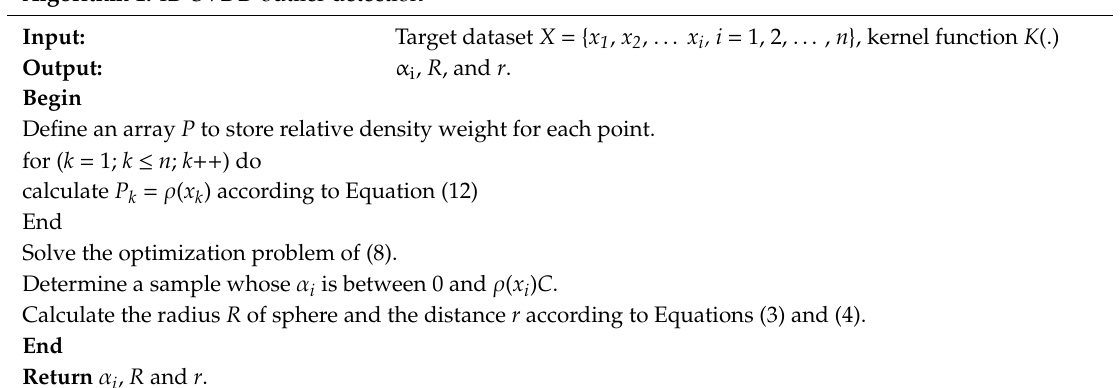
Algorithm 1. ID-SVDD outlier detection